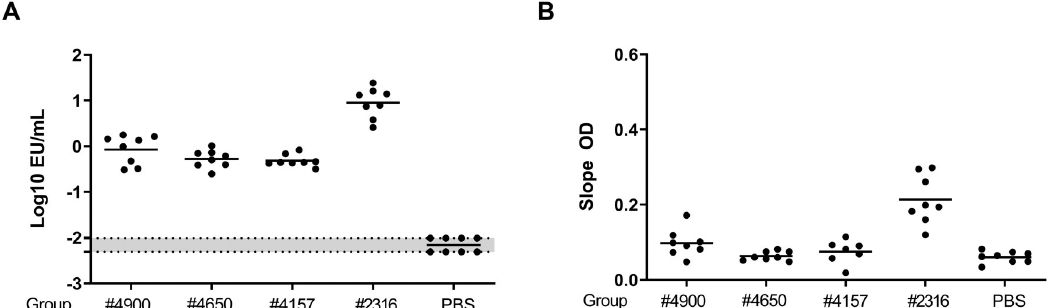
Fig 4. Early post-boost immunization antibodies do not correlate with protection conferred by mini-HA immunizations. (A) ELISA titers against full-length HA derived from A/Brisbane/59/07 (same antigen as FL H1#2316) were determined in serum obtained at day 25 (4 days after the first boost immunization) from mice (n = 8 per group) immunized with high doses (30 μ g or 60 μ g) of the indicated antigens or PBS, all adjuvanted with alum. (B) Inhibition of CR9114 binding to A/Brisbane/59/07 determined by ELISA after pre-incubation of A/Brisbane/59/07 with day 25 post-boost serum antibodies from the same mice. Every dot represents data from a single animal, horizontal bars specify group means. In panel A, the grey area between dotted lines represents the highest and lowest LOD of the assay, which is calculated per each plate. Statistical comparisons are made by comparing group means of the miniHA vaccinated animals in a one-way ANOVA, corrected for multiple comparisons using Tukey’s statistical hypothesis testing.